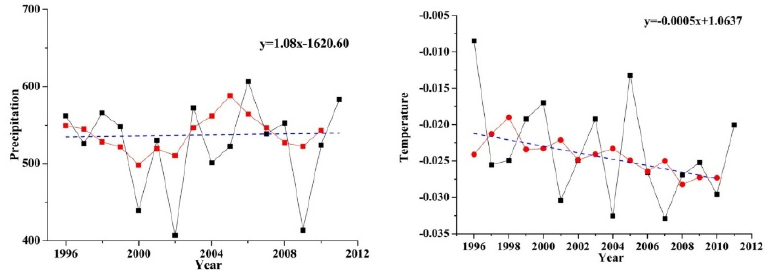
Figure 7. Annual change in temperature and precipitation of the study region from 1996 to 2011. The black line is drawn according to the climate data from Linxia meteorological station, gray lines are the change trends of three study intervals (1996–2001, 2001–2006, 2006–2011), and the red dot lines represent the three-point running